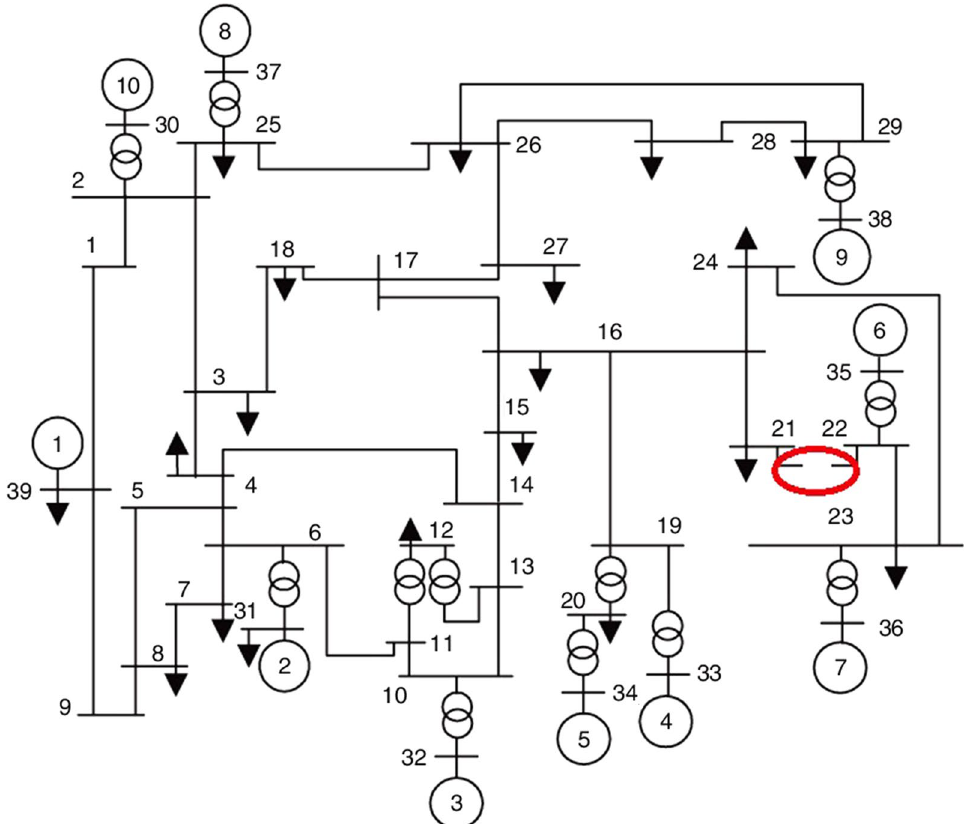
Fig. 9 Scenario 1 of case 2